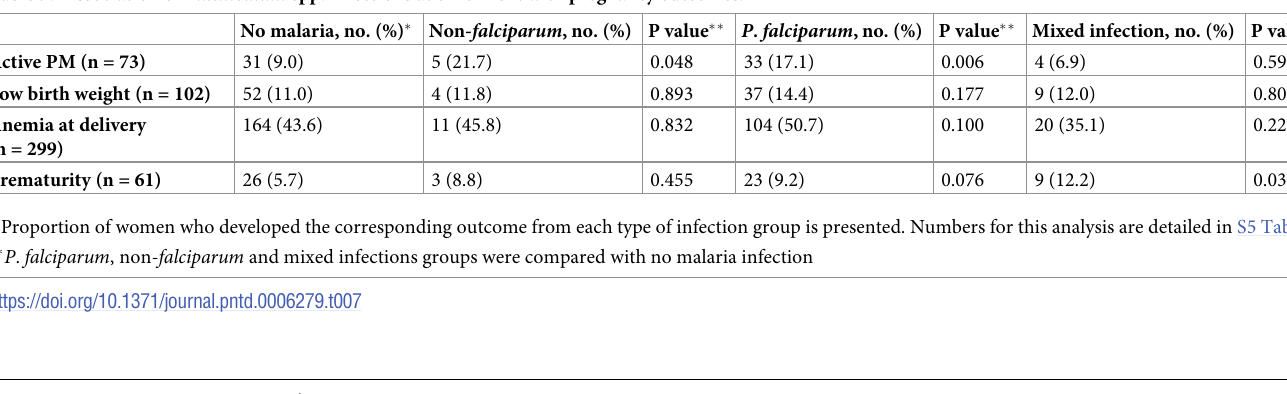
anaemia at delivery were investigated (Tables 7 and 8). The proportion of women who devel- oped each outcome from P . falciparum , non- falciparum and mixed infections groups was com- pared to the group of women with no malaria infection at delivery. Number of pregnant women with malaria infection in the placental blood determined by microscopy was signifi- cantly higher in women who were infected early in pregnancy with either non- falciparum or P . falciparum (p = 0.048 and p = 0.006, respectively), as compared to uninfected women at enrol- ment (Table 7). Noteworthily, only P . falciparum infections were significantly associated to maternal anemia at enrolment (S4 Table). No relationship was observed between non- falcipa- rum , P . falciparum and mixed infections at enrolment, and the occurrence of LBW and mater- nal anemia at delivery. Nevertheless, mixed infection at enrolment was significantly related to premature delivery (p = 0.037), and a similar trend was found for P . falciparum infected moth- ers at enrolment and at delivery. Table 7. Association of Plasmodium spp. infections at enrolment with pregnancy